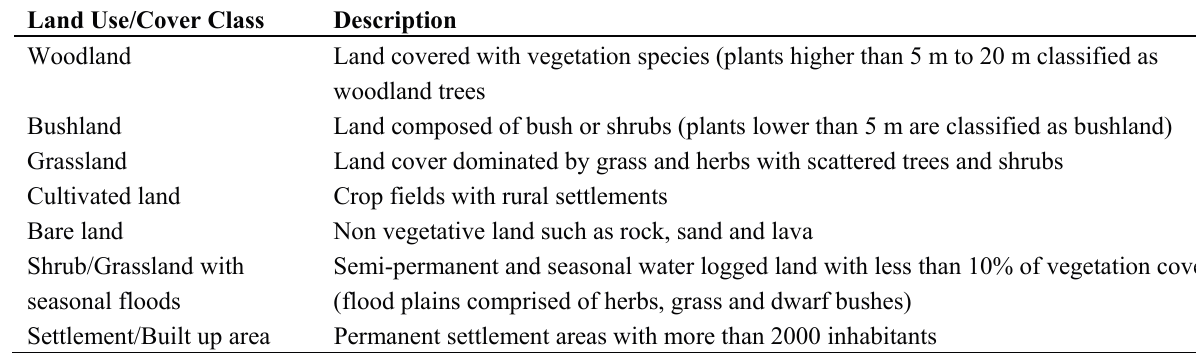
Table 1. Description of the criteria used to classify land use and land cover